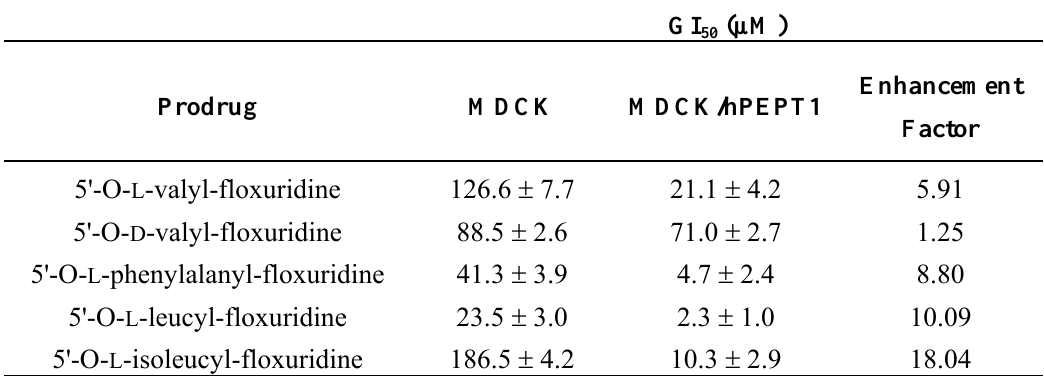
Table 4. Effect of hPEPT1 in MDCK Cells for Cell Proliferation